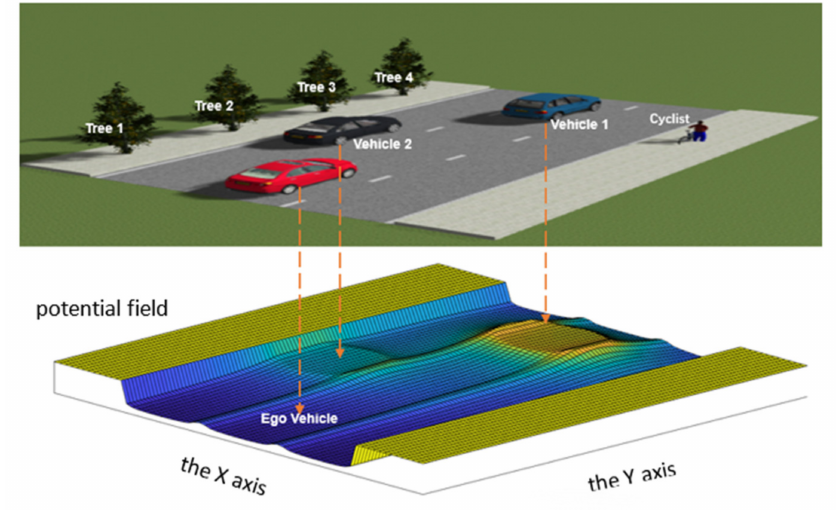
Figure 3. The results of potential field of the highway traffic